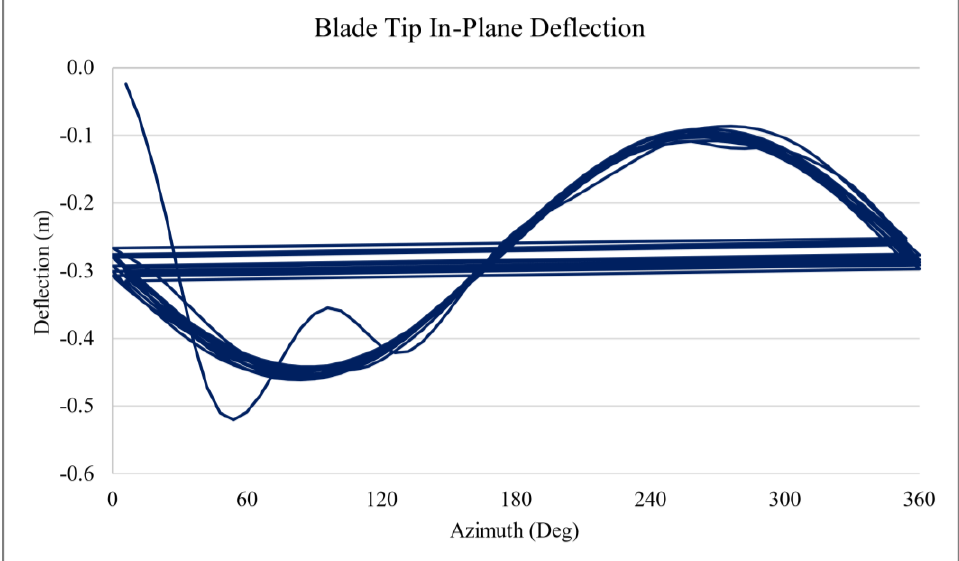
Figure 14. Blade Tip In-Plane Deflection with Azimuth Angle - 1% Turbulence Intensity